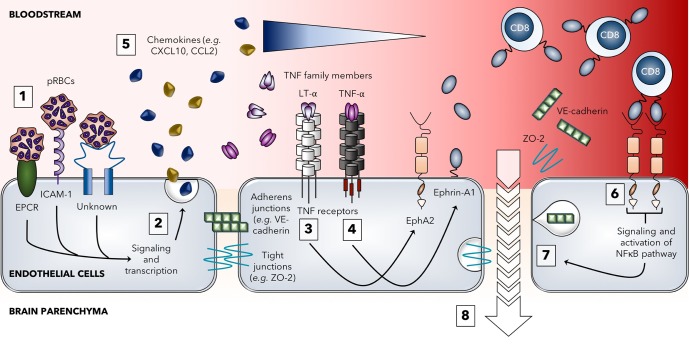
Model for the role of EphA2 in the development of experimental cerebral malaria.The breakdown of the blood-brain barrier during blood-stage PbA infection begins with parasitized red blood cells (pRBCs) in the schizont stage traveling through the bloodstream and adhering to various receptors expressed on brain microvascular endothelial cells including EPCR, ICAM-1, and other unknown receptors that have yet to be identified (1). Signaling through these receptors leads to endothelial activation (2) and release of various pro-inflammatory cytokines and chemokines. The cytokine LT-α can act on proximal endothelial cells to induce upregulation of the receptor EphA2 (3) while TNF-α induces upregulation of ephrin-A1 ligand (4) which can be cleaved by metalloproteinases and released into the bloodstream (although this monomeric form is not believed to signal). Chemokines such as CXCL10 and CCL2 recruit circulating immune cells, including CD8+ T cells, to the brain to the site of inflammation (5). Upon entry into the brain microvasculature, CD8+ T cells expressing ephrin-A1 ligand bind to EphA2 expressed on brain endothelial cells leading to clustering and activation of EphA2. Forward signaling cascades from the EphA2 receptor lead to activation of the NFκB pathway (6) which results in various downstream consequences including disruption of endothelial cell junctions due to both internalization and shedding of different adherens and tight junction protein components (7). Once brain endothelial cell junctions are disrupted, contents of the vasculature can leak into the brain parenchyma (8) leading to vascular leakage, brain edema, and the development of other neurological symptoms associated with PbA infection. In the absence of EphA2 upregulation or activation (i.e. EphA2 deficiency, PbNK65 infection, therapeutic targeting), this endothelial junction disruption does not occur and the blood-brain barrier remains intact.